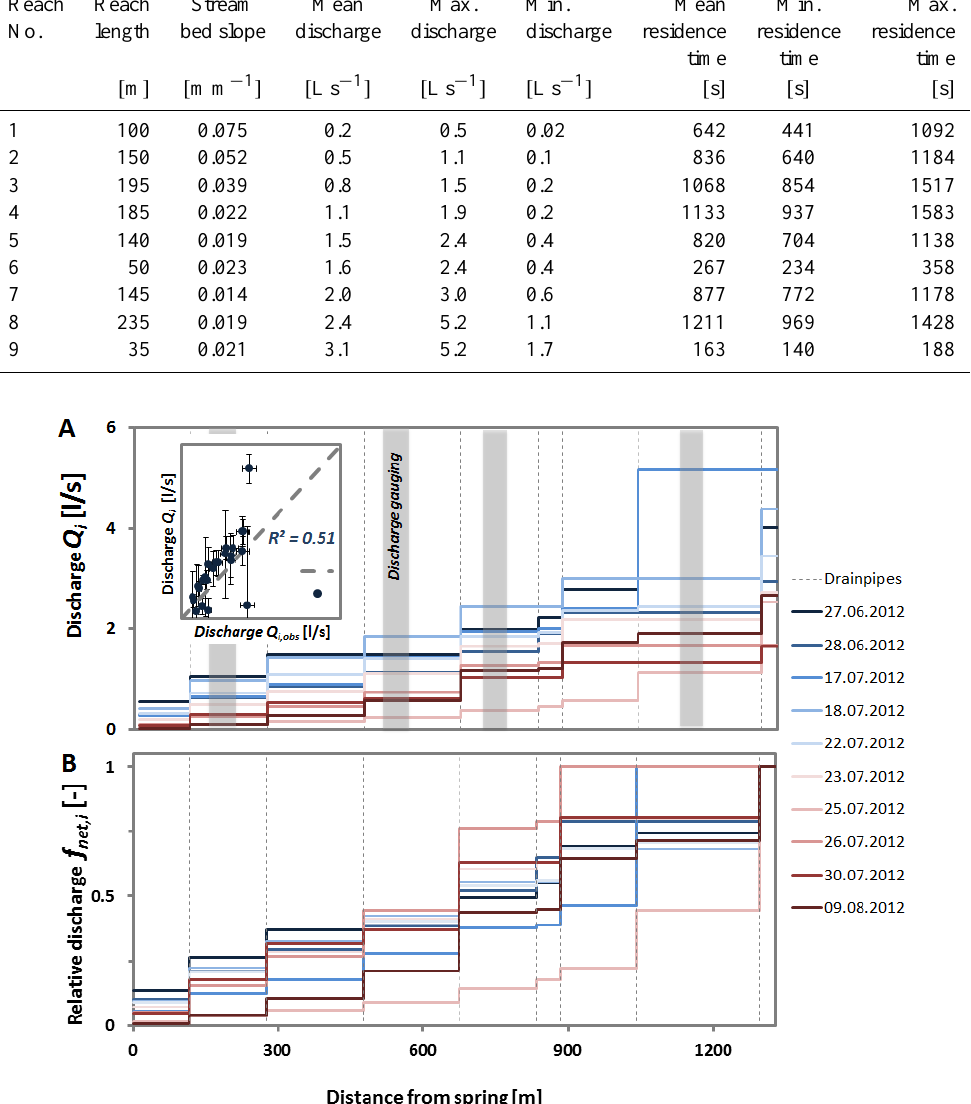
Figure 3. (a) Simulated stream network discharge patterns Q i for all days. Inset in (a) : comparison of calculated ( Q i ) and measured discharges ( Q i, obs ). (b) Calculated patterns of relative discharges f net ,i for all days. Sampling campaigns No. 1–No. 10 are colour-coded from blue to red. Dashed lines (a, b) symbolize the positions of the drainpipes. Shaded bars (a) represent the locations of salt dilution